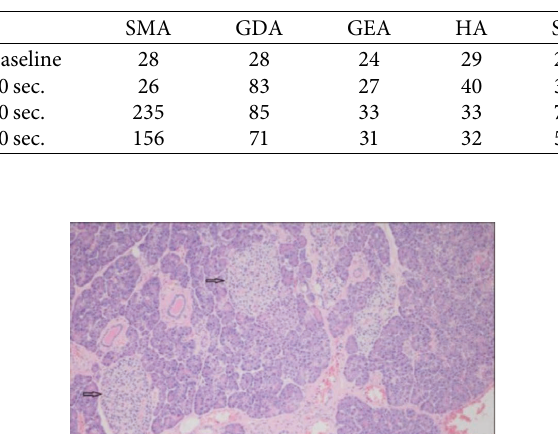
Table 1: Insulin concentrations (pmol/L) measured during SACST, at baseline levels, and then 20, 40, and 60 seconds after calcium gluconate injection.